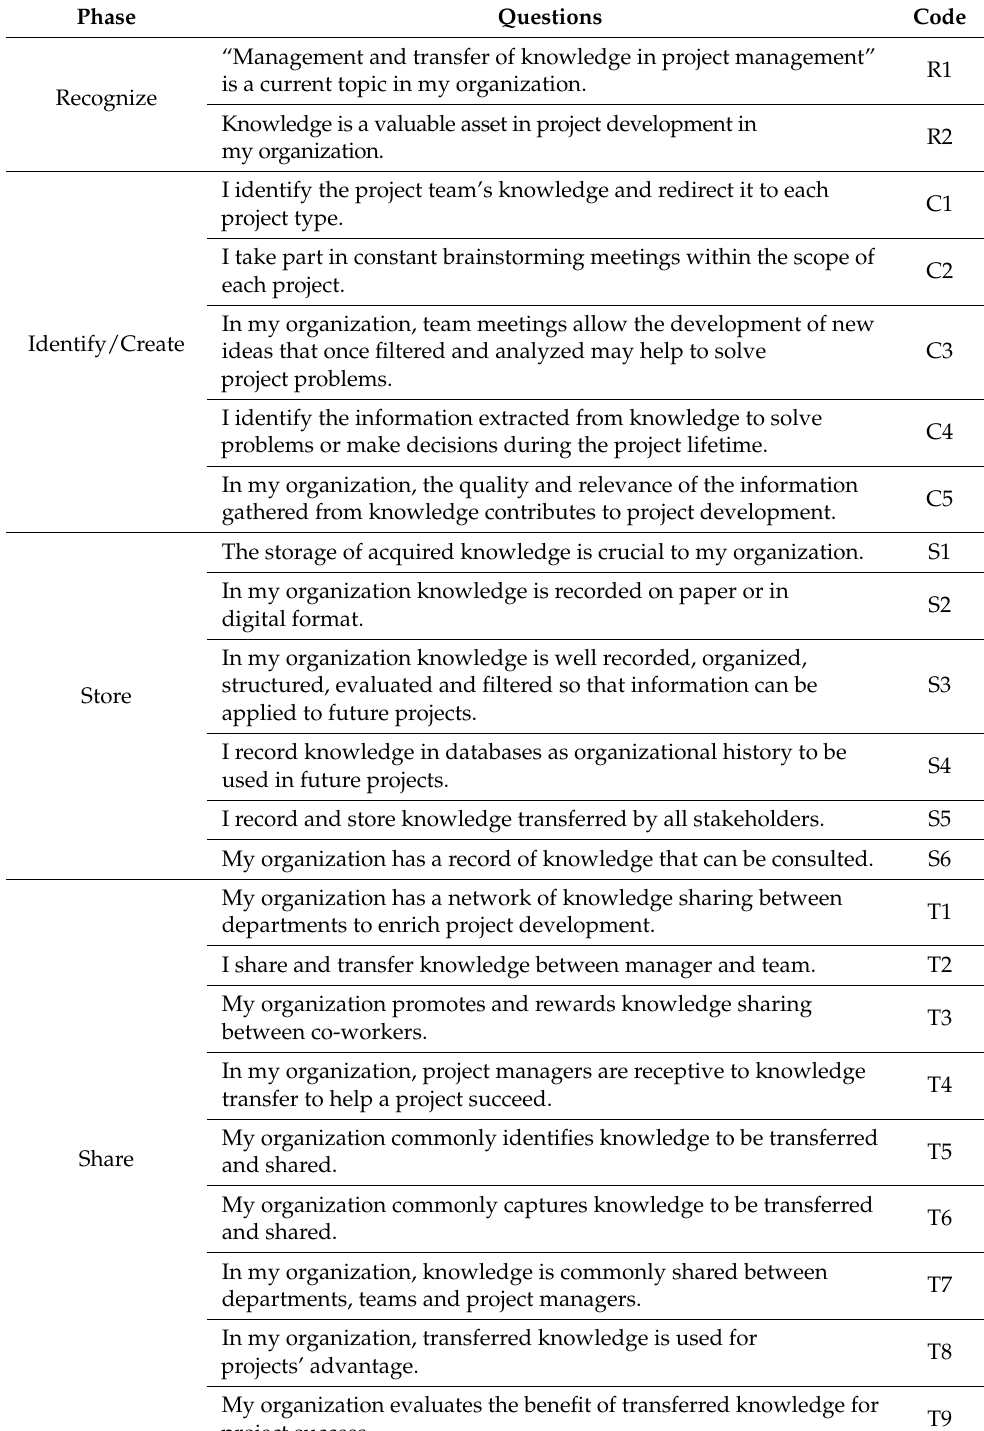
Table 2. Survey questions by KM